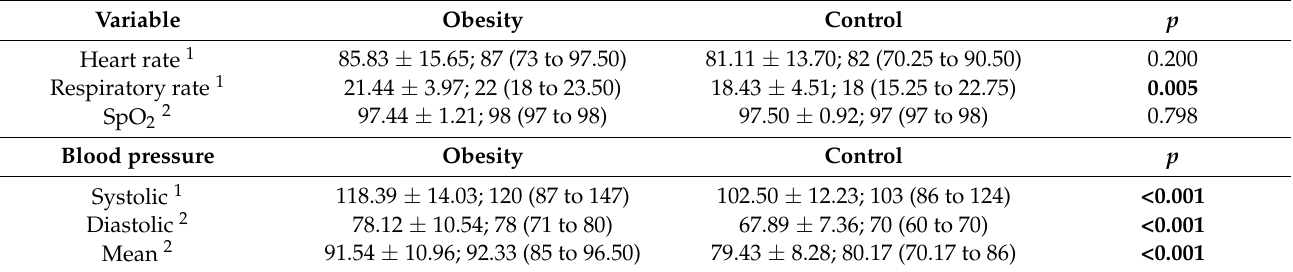
Table 3. Comparison between the vital signs of participants with and without obesity.